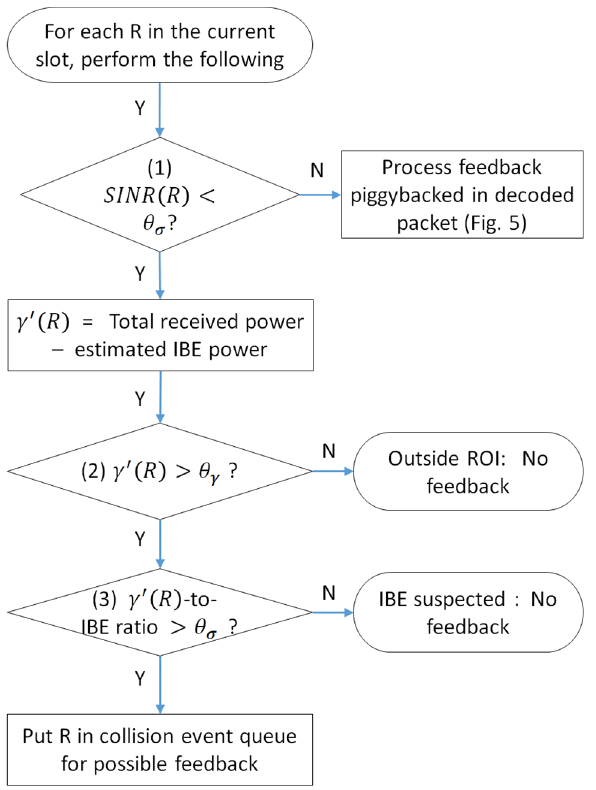
Figure 2. Logic to determine whether to provide a feedback at the broadcast receiver.